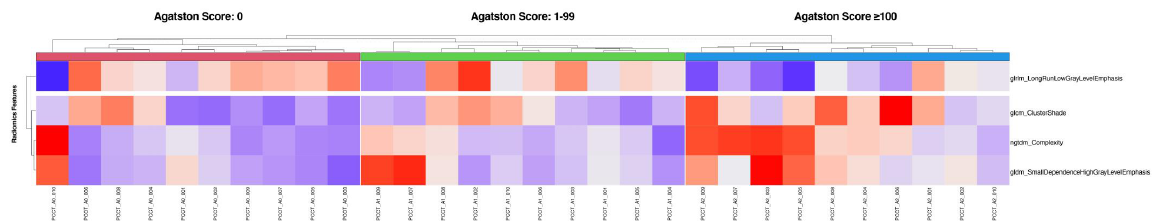
Figure 6. Unsupervised cluster heatmap of “gldm SmallDependenceHighGrayLevelEmphasis”, “glcm ClusterShade”, “glrlm LongRunLowGrayLevelEmphasis”, and “ngtdm Complexity” feature of 30